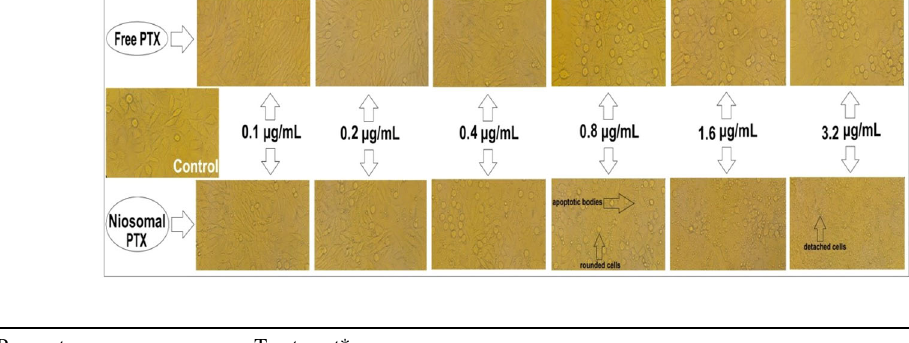
Table 3 Effects of free PTX and niosomal PTX on hematological parameters, biochemical parameters, and liver MDA content of different experimental groups